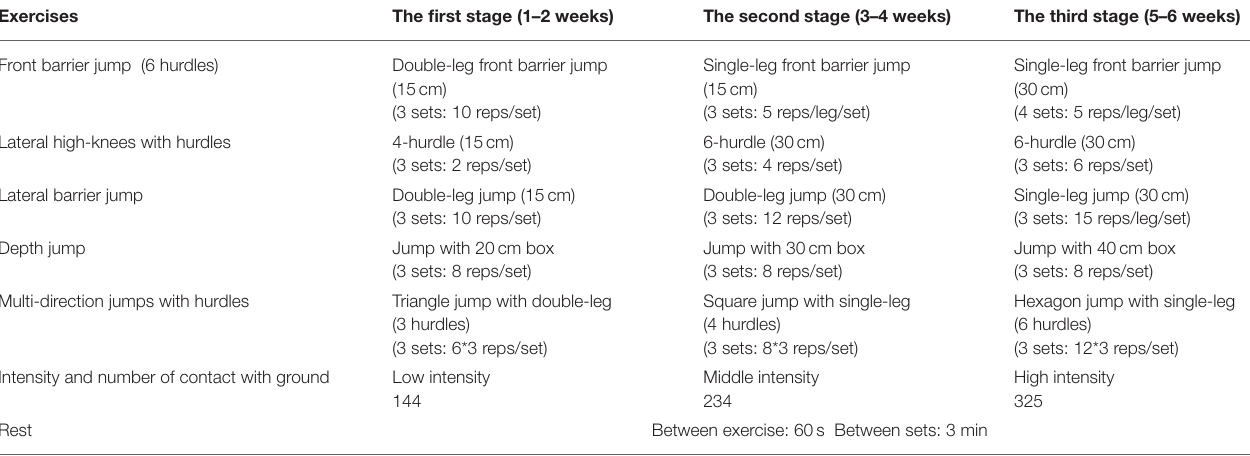
TABLE 2 | The plyometric training program for BP and plyometric (PL) training group.